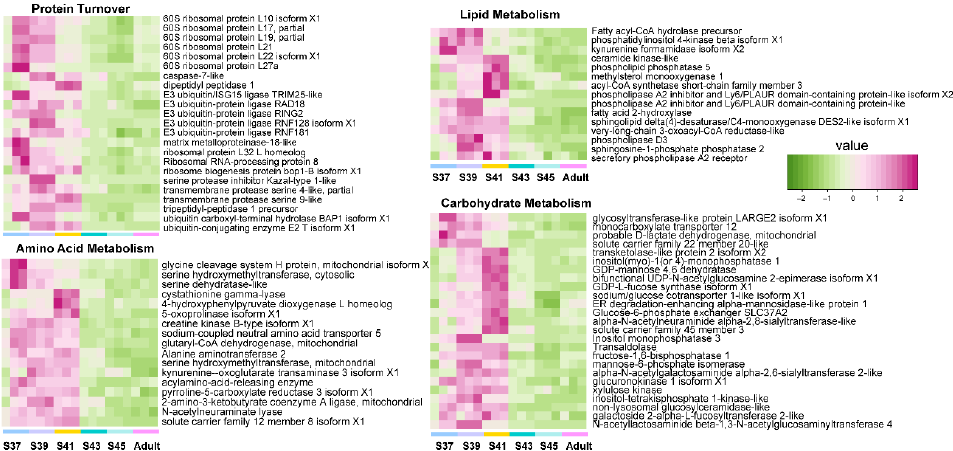
Figure 3. The variation patterns of featured genes involved in protein turnover, lipid metabolism, amino acid metabolism, and carbohydrate metabolism in the pro-metamorphic phase ( n = 3 each stage).